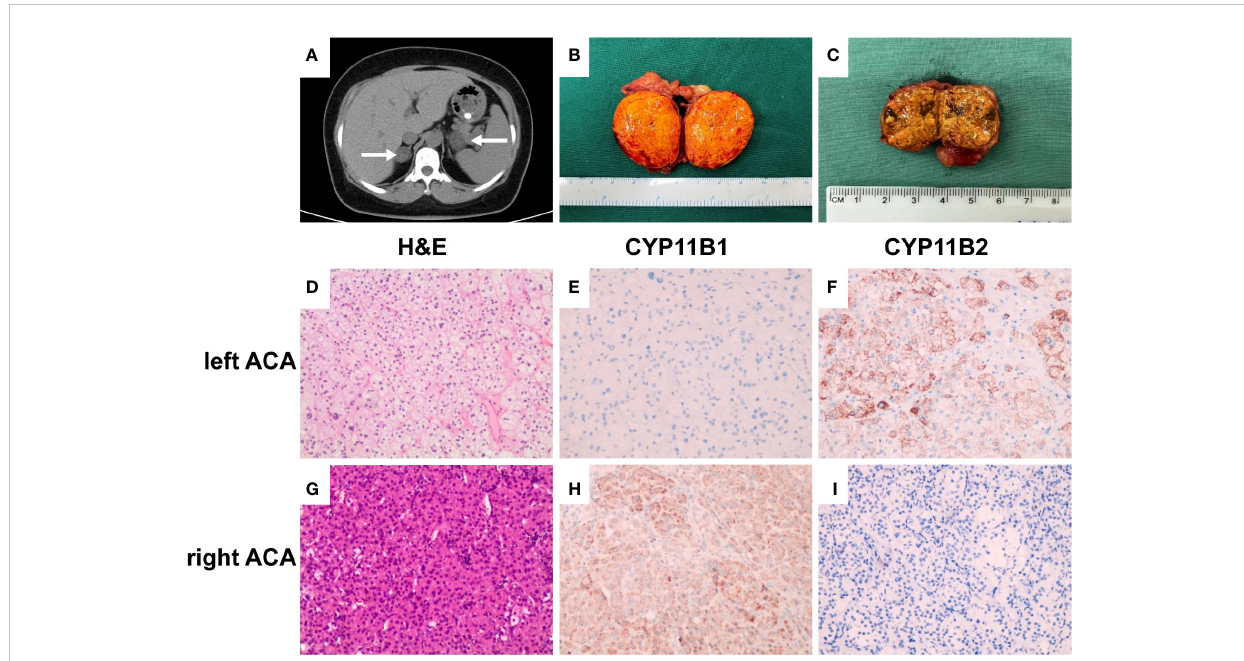
FIGURE 1 Enhanced computerized tomography (CT), pathological and immunohistochemical fi ndings. (A) CT scan revealed bilateral adrenocortical adenomas, with the left adenoma of 38 × 28 mm and the right adenoma of 25 × 21 mm (white arrows). (B) Gross pathology of the resected left adrenal tumor showing a bright yellow well-circumscribed mass arising from the cortex. (C) Gross pathology of the resected right adrenal tumor showing a brownish yellow, relatively solid area. (D, G) H&E stain results, (×200); (E, F, H, I) immunostaining (×200). Left adrenocortical adenoma (left ACA, predominately secreted aldosterone) consisting primarily of clear cells, CYP11B1 ( − ) and CYP11B2 (+). Right adrenocortical adenoma (right ACA, predominately secreting cortisol) was composed of both eosinophilic compact cells and clear cells, with the former accounting for 60%, CYP11B1 (+) and CYP11B2 ( −